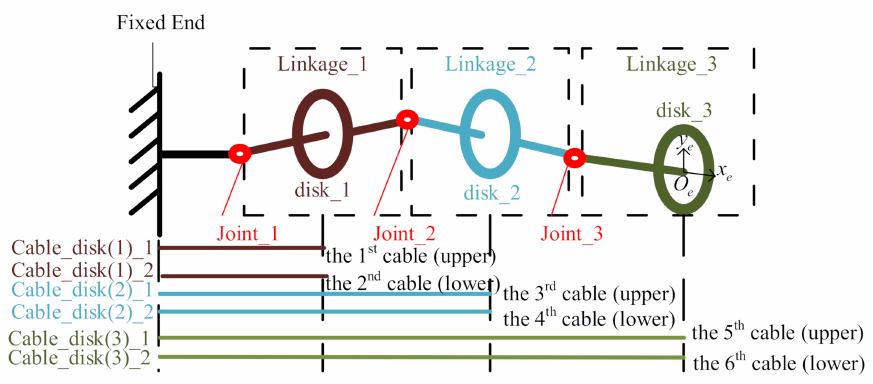
Figure 4. 3-DOF planar CDSM (driven by 6 cables).